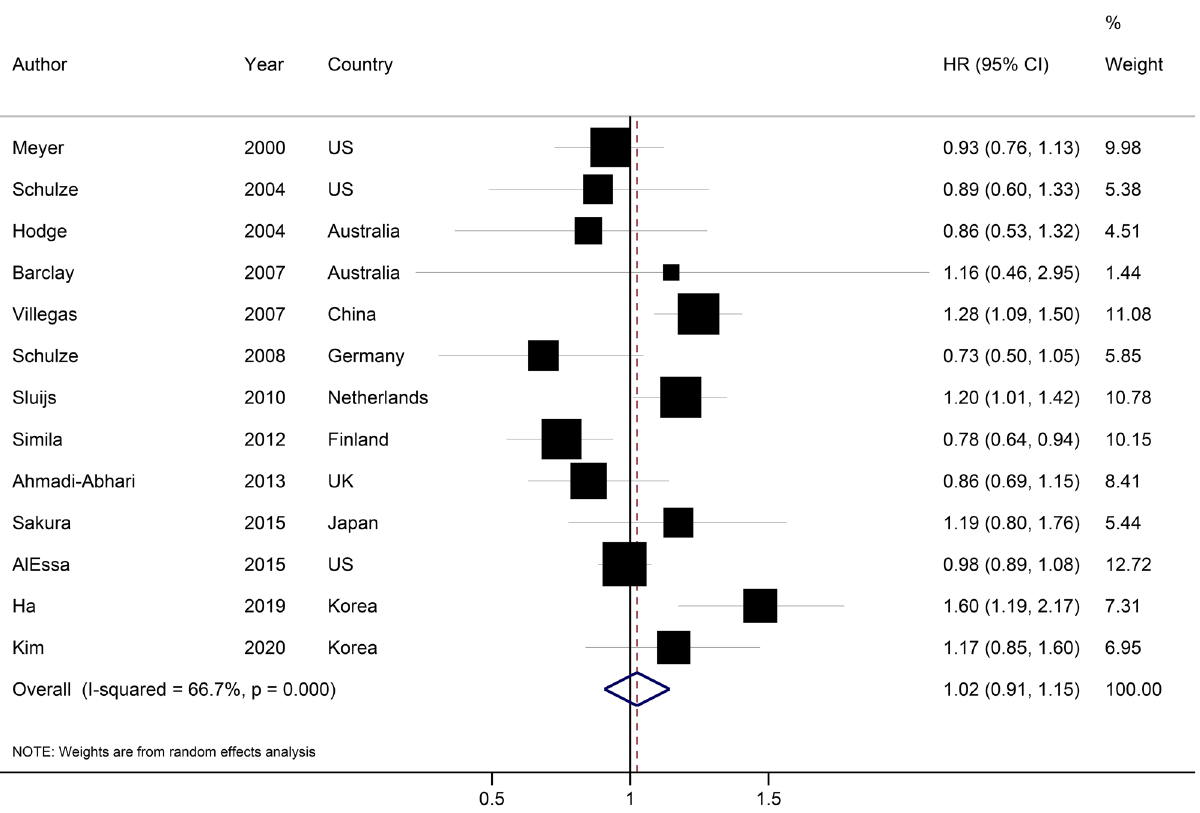
Figure 1. Hazard ratio of type 2 diabetes for the highest compared with the lowest category of type 2 diabetes. HR Hazard